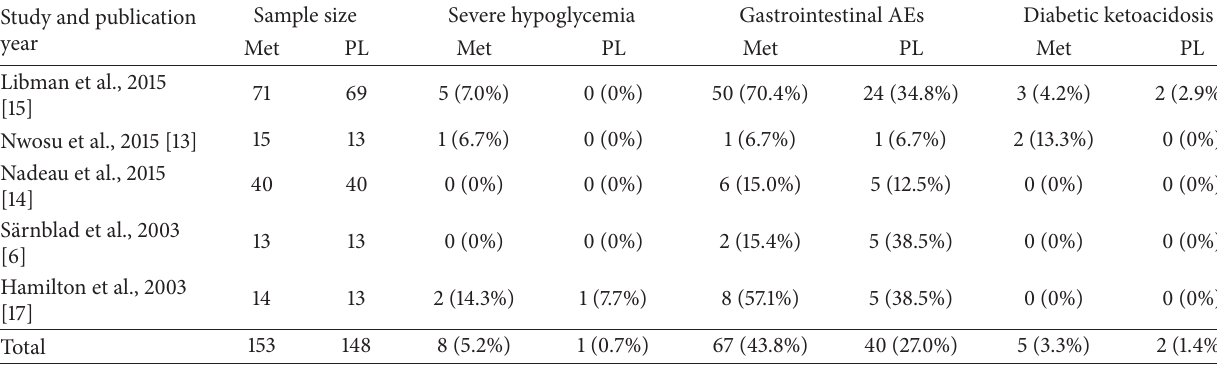
Table 3: Summary of adverse events.